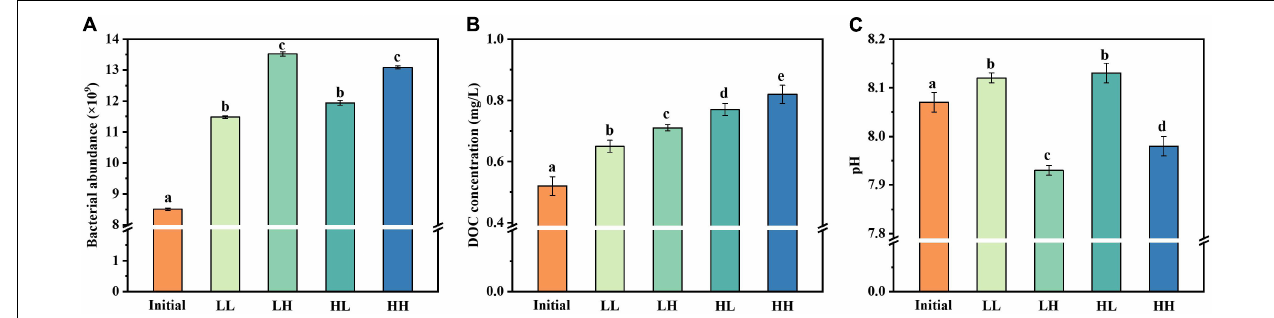
FIGURE 1 | Changes in (A) bacterial abundance, (B) DOC concentration, and (C) pH under warming and acidification conditions. Initial, initial value; LL, 27 ◦ C and 400 ppm; LH, 27 ◦ C and 1,000 ppm; HL, 31 ◦ C and 400 ppm; HH, 31 ◦ C and 1,000 ppm. All data are presented as mean ± SD ( n = 3). Error bars represent the standard error for duplicate cultures. Different letters (e.g., “a,” “b,” “c,” “d,” and “e”) represented significant difference ( p < 0.05), as determined by a one-way analysis of variance (ANOVA).